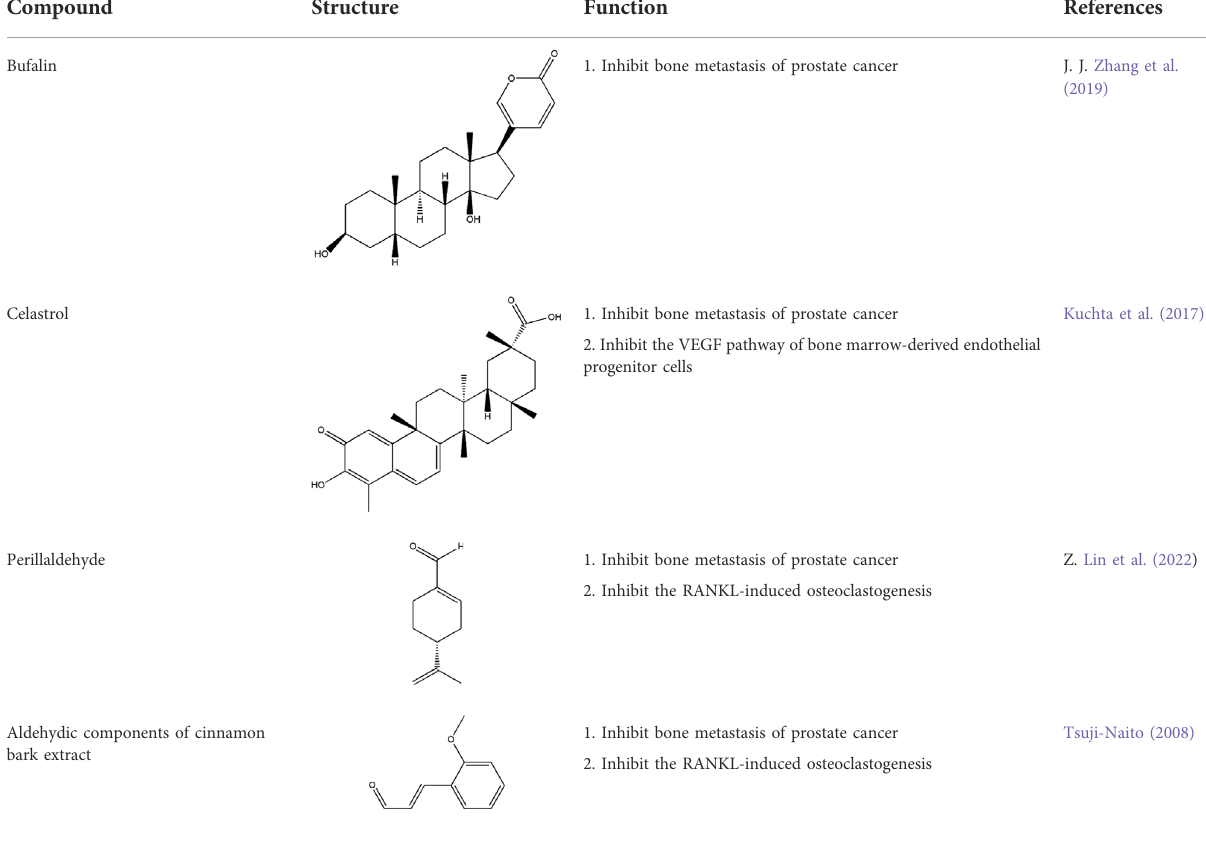
TABLE 2 Chemical structure and function of traditional Chinese medicine monomer in